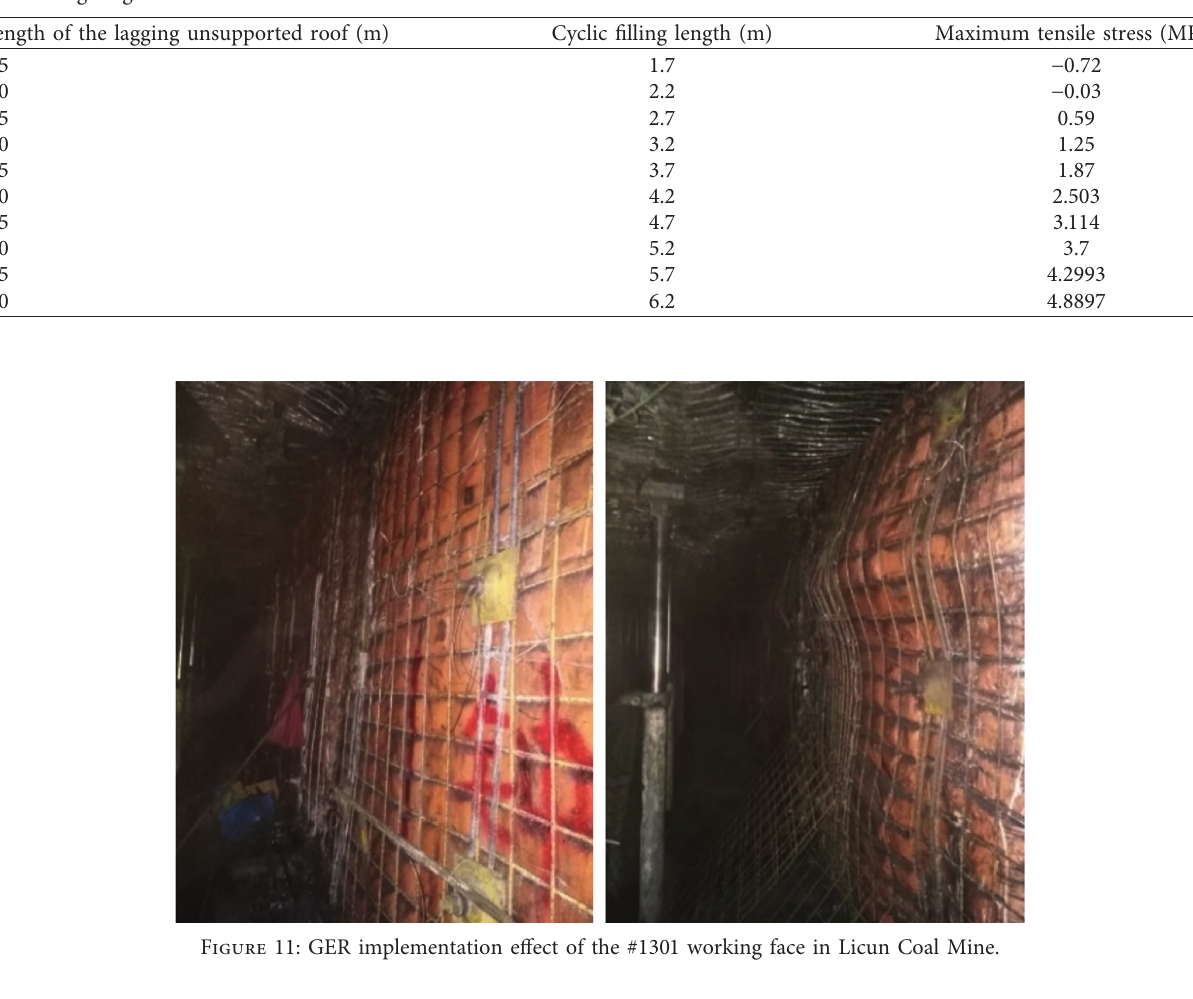
Table 2: Maximum tensile stress of the lower immediate roof in GER-RF with respect to the length of the lagging unsupported roof and cyclic filling length.